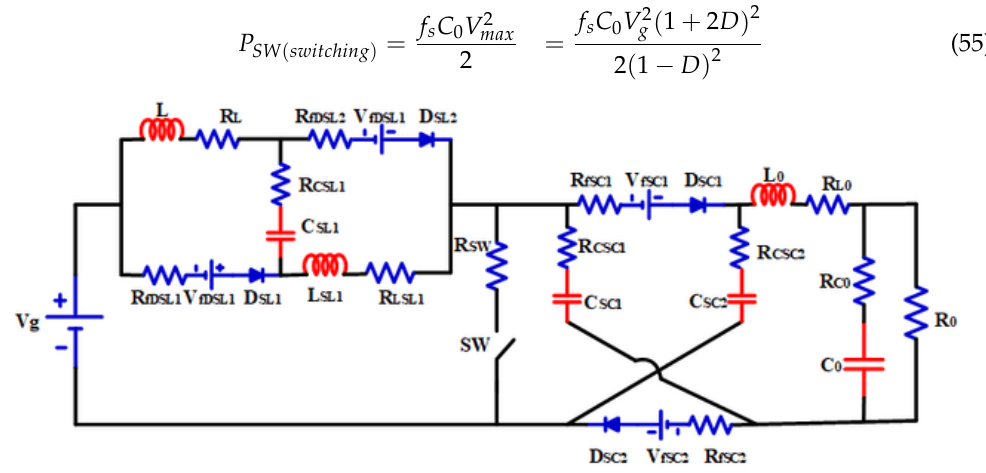
Figure 10. Equivalent circuit of PSLSC converter.